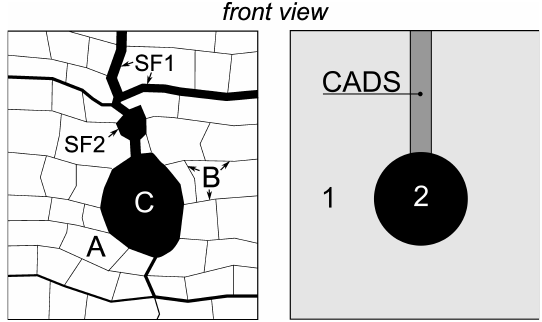
Fig. 2. Left: Sketch of a karst aquifer with (A) porous rock matrix, (B) small fissures/fractures, (C) solution-enlarged conduits with ac- tive flow, (SF1) solution-enlarged fractures, and (SF2) other karst cavities, both without active flow. Right: discrete-continuum model concept with (1) matrix continuum, (2) discrete pipes, and conduit- associated drainable storage